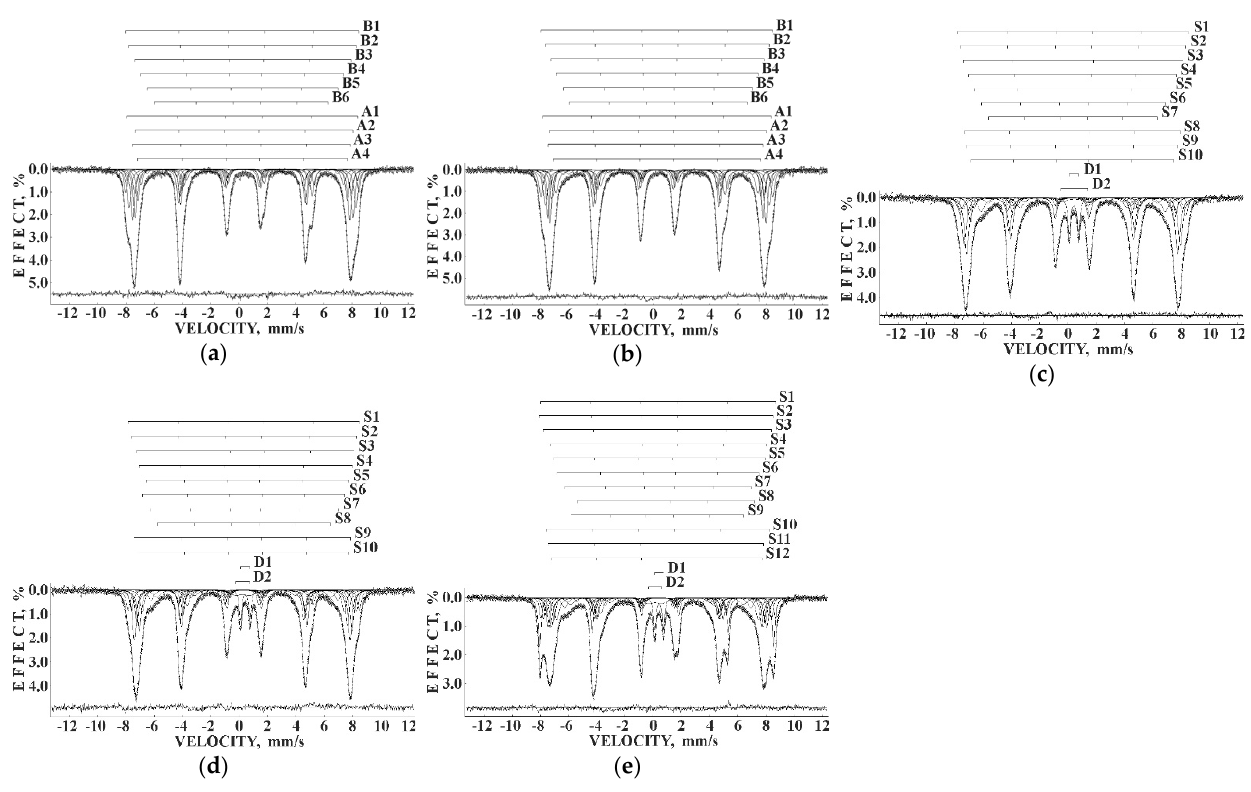
Figure 61. Mössbauer spectrum of CuFe 2 O 4 measured with a high velocity resolution and con ‐ verted into the 1024 ‐ channel spectrum and fitted using three magnetic sextets without the differ ‐ ential spectrum, adapted from Ref. [91] with permission from Springer Nature: Hyperfine Interac ‐ tions, “Study of CuFe 2 O 4 –SnO 2 nanocomposites by Mössbauer spectroscopy with high velocity resolution”, Oshtrakh M.I., Kalai Selvan R., Augustin C.O., Semionkin V.A., ©2008. ( a ) and the same fit with the differential spectrum on the bottom showing large misfits ( b ).